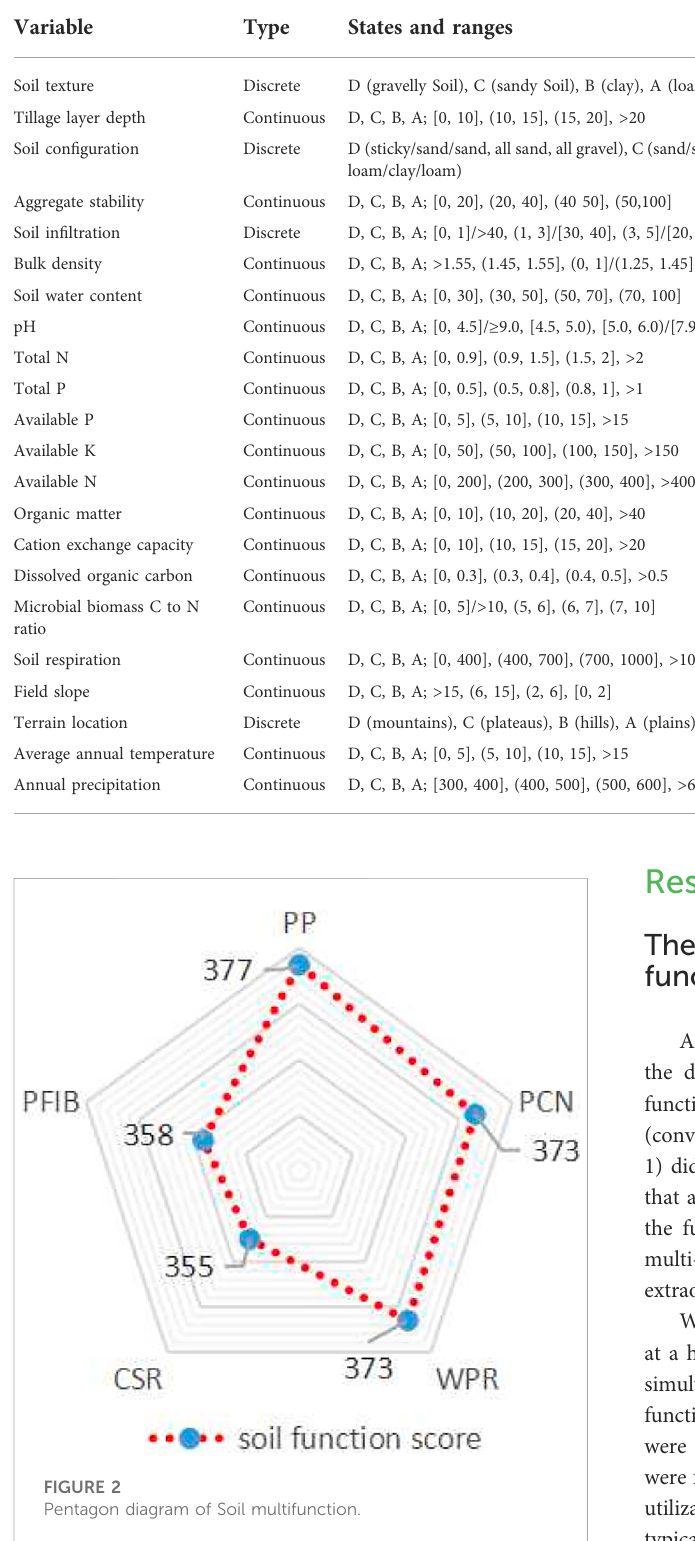
TABLE 4 Description of some network nodes.